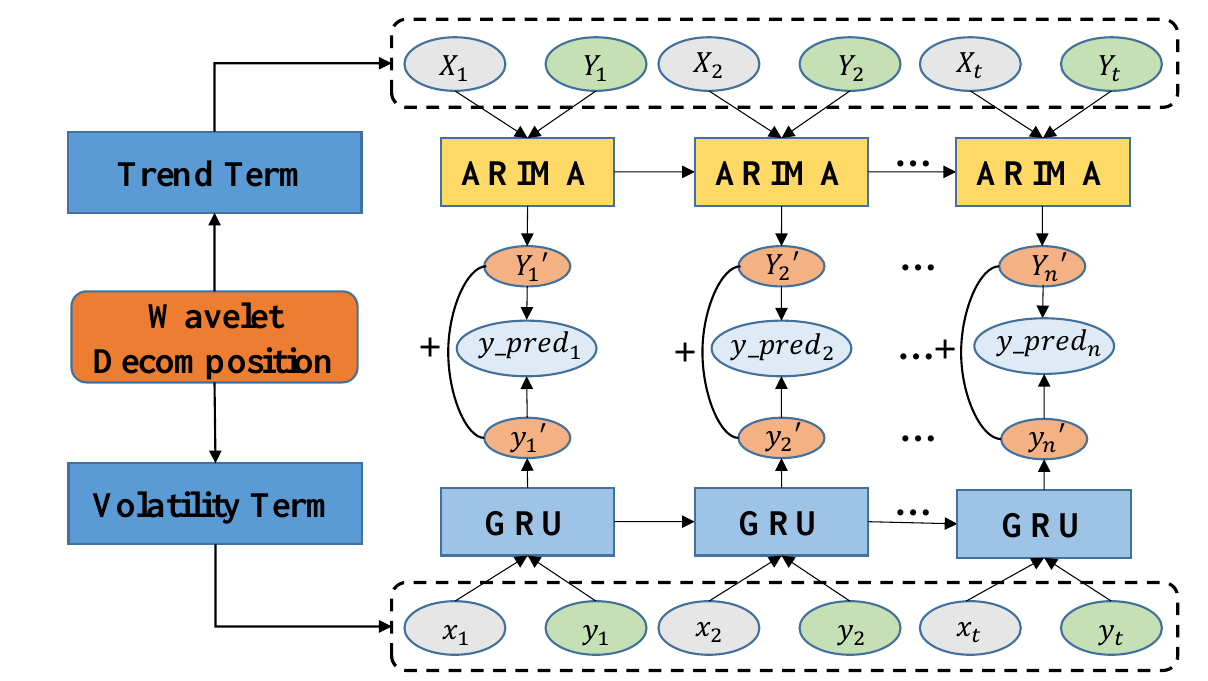
Figure 12. Basic structure of water quality indicator prediction combination model.